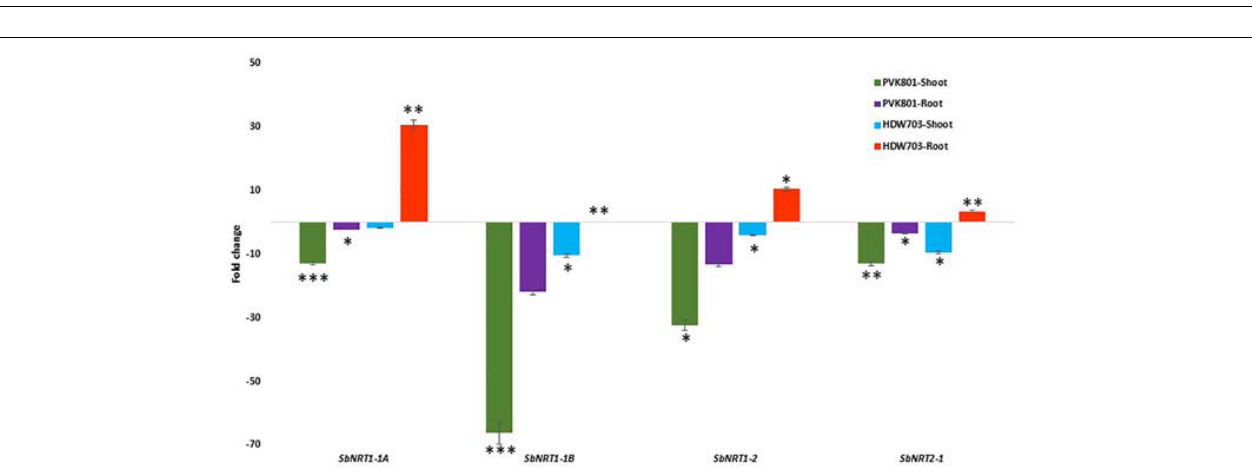
FIGURE 6 | Expression profiles of SbNRT genes in shoot and root samples of high (PVK801) and low NUE (HDW703) genotypes, under N0 condition. Here N0 condition taken as treated and N100 used as control. *, **, and *** denotes significance at 5, 1, and 0.1% P, remaining not significant.